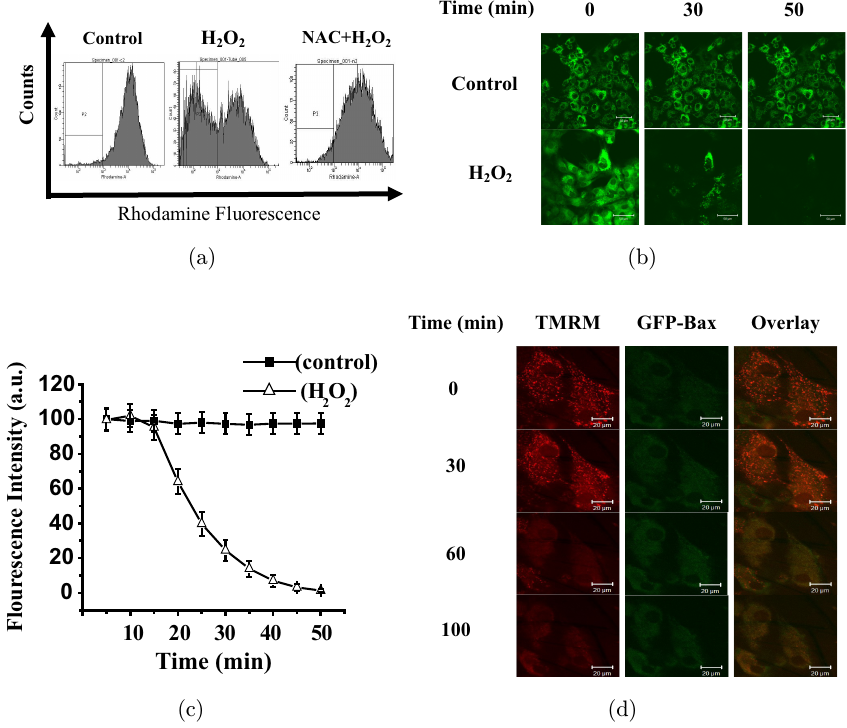
Fig. 2. H 2 O 2 induces a loss of mitochondrial membrane potential. (a) FCM analysis of H 2 O 2 -induced loss of mitochondrial membrane potential ( (cid:1)(cid:2) m ). The cells stained with 10 (cid:2) M Rho 123 for 30 min were treated with H 2 O 2 in the presence or absence of NAC for 30 min. The number in left quadrant represents the percentage of cells with reduction in (cid:1)(cid:2) m . (b) Dynamics of °uor- escence images of cells stained with Rho 123 by confocal time-lapse °uorescence microscopy. Scale Bar: 50 (cid:2) m. (c) Dynamics of °uorescence intensities of Rho 123 inside live cells corresponding to (b). (d) Spatio-temporal distribution of Bax and mitochondria inside live cells in control and H 2 O 2 -treated cells, respectively by confocal microscopy imaging. Cells were transfected with GFP-Bax and stained with TMRM to °uorescently label mitochondria and Bax, respectively. Scale Bar: 20 (cid:2)